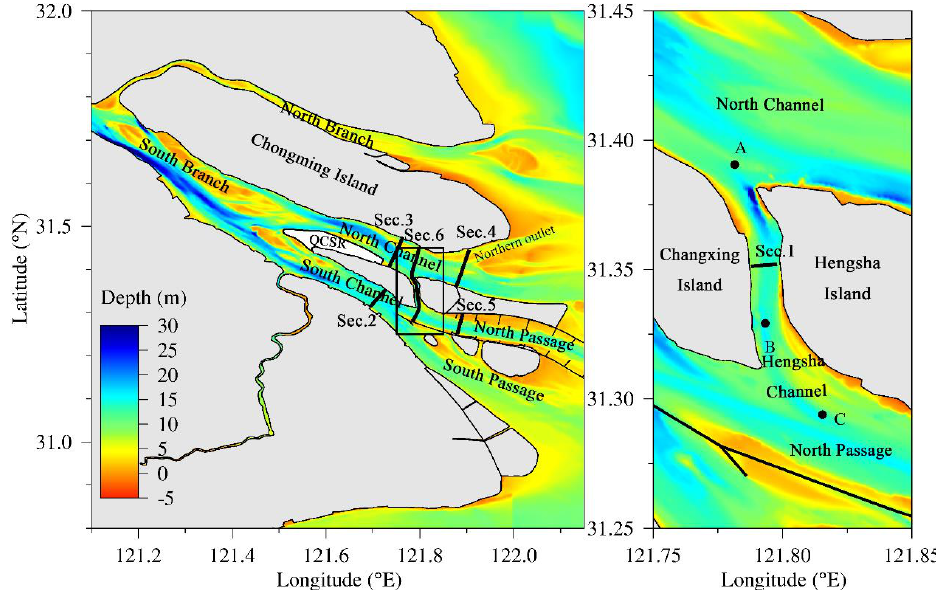
Figure 1. Topography of the Changjiang Estuary ( left ) and the locations of the observation sites around the HC ( right ). Black solid circles are the anchored ship observation sites. Sec.1, Sec.2, Sec.3, Sec.4, Sec.5 and Sec.6 are the sections of water and salt